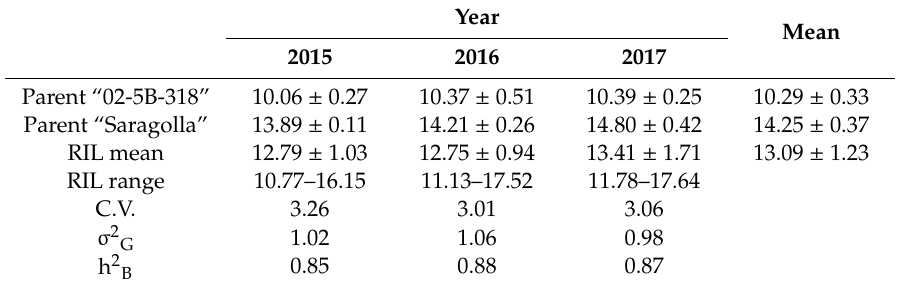
Table 1. Yellow index (YI ± SE) values of the parental lines and the Recombinant Inbred Line (RIL) population grown in Valenzano for three years. C.V., coe ffi cient of variation; σ 2 G , genetic variance; h 2 B , broad-sense